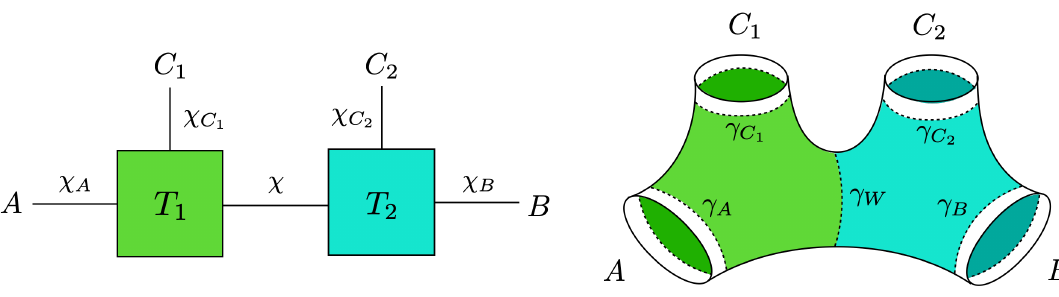
Figure 2 . (left) The 2TN tensor network considered in this section is built from two random tensors T 1 and T 2 . The parameters are the boundary bond dimensions χ A , χ B , χ C bond dimension χ . (right) The wormhole solution that is modeled by 2TN. The external bond dimensions corresponds to the three horizon areas and the internal bond dimension χ corresponds to the cross-section surface γ W